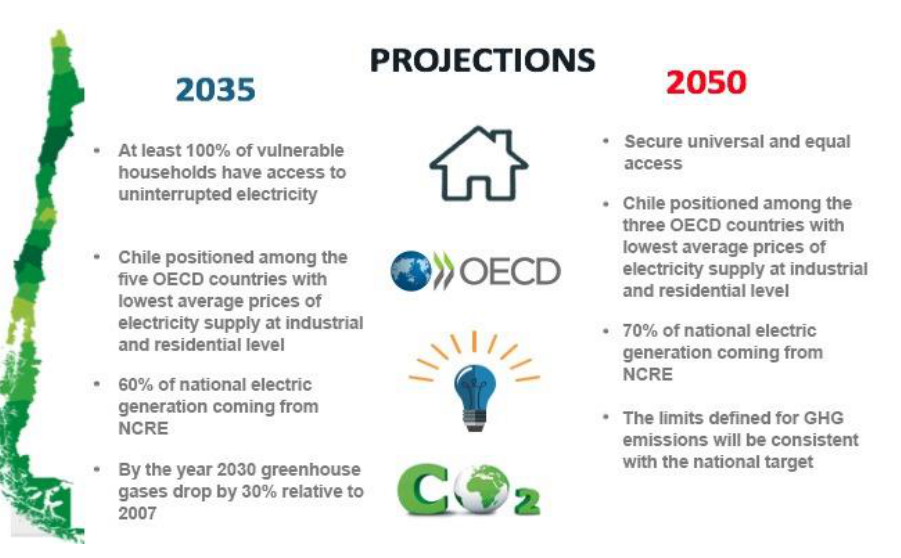
Figure 4. Necessary measurements for electric generation resulting from renewable energies 2035 and 2050. Source: